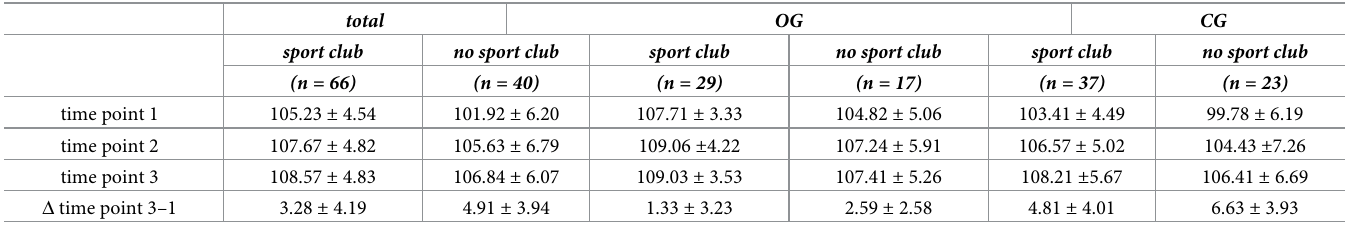
Table 4. Motor performance score separated by sports club membership and